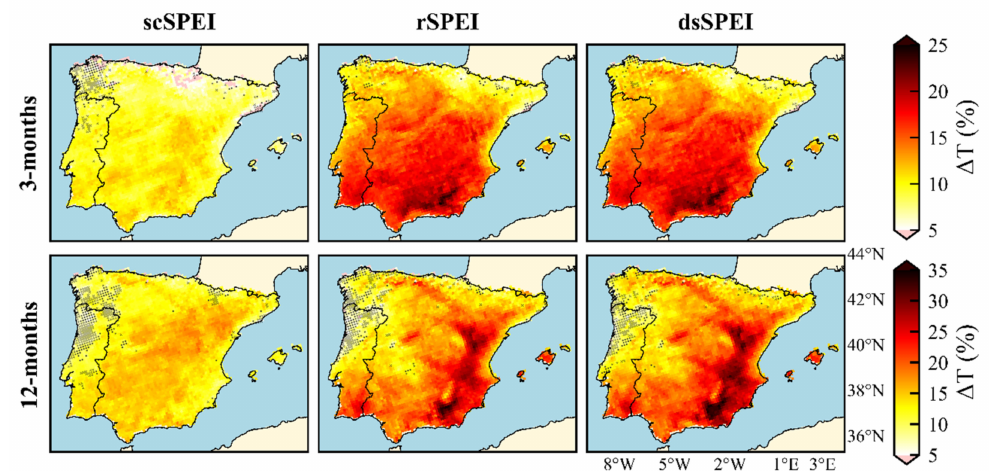
Figure 7. Changes (future minus recent past) in the percentage of time spent in droughts ( ∆ T, %) for the three methods analyzed (scSPEI, rSPEI, and dsSPEI) and at both timescales (3- and 12-month) for the near future. The dashed areas indicate that less than 12 models agree in the sign of the changes with the ensemble